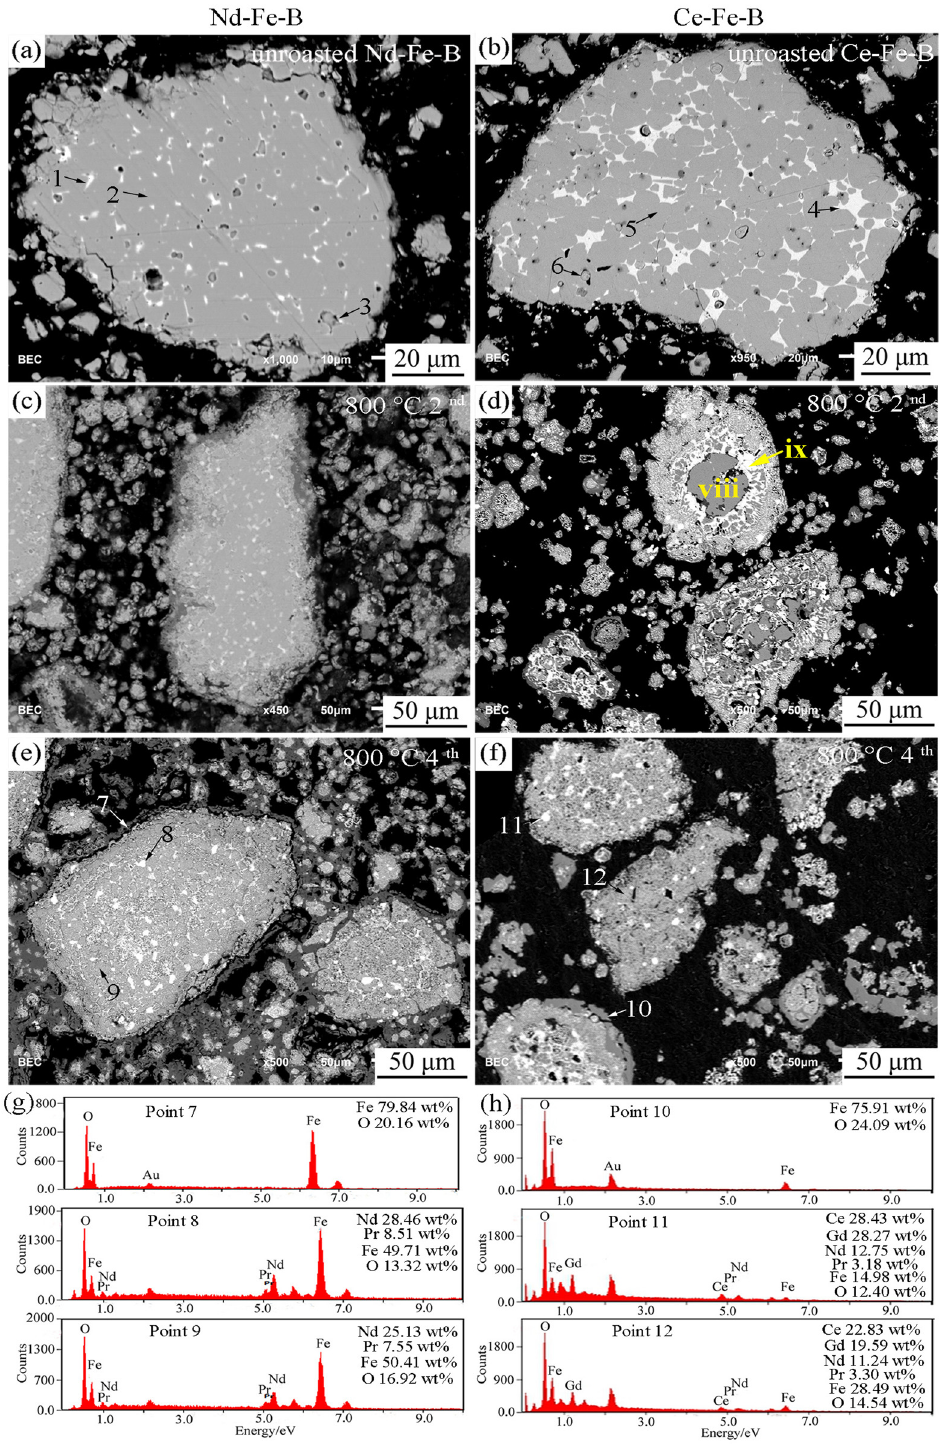
Figure 6: Typical BSE microstructures of the Nd – Fe – B and Ce – Fe – B magnet scrap powders roasted at 800°C and EDS analysis. ( a, c, e and g ) Nd – Fe – B; ( b, d, f and h ) Ce – Fe –